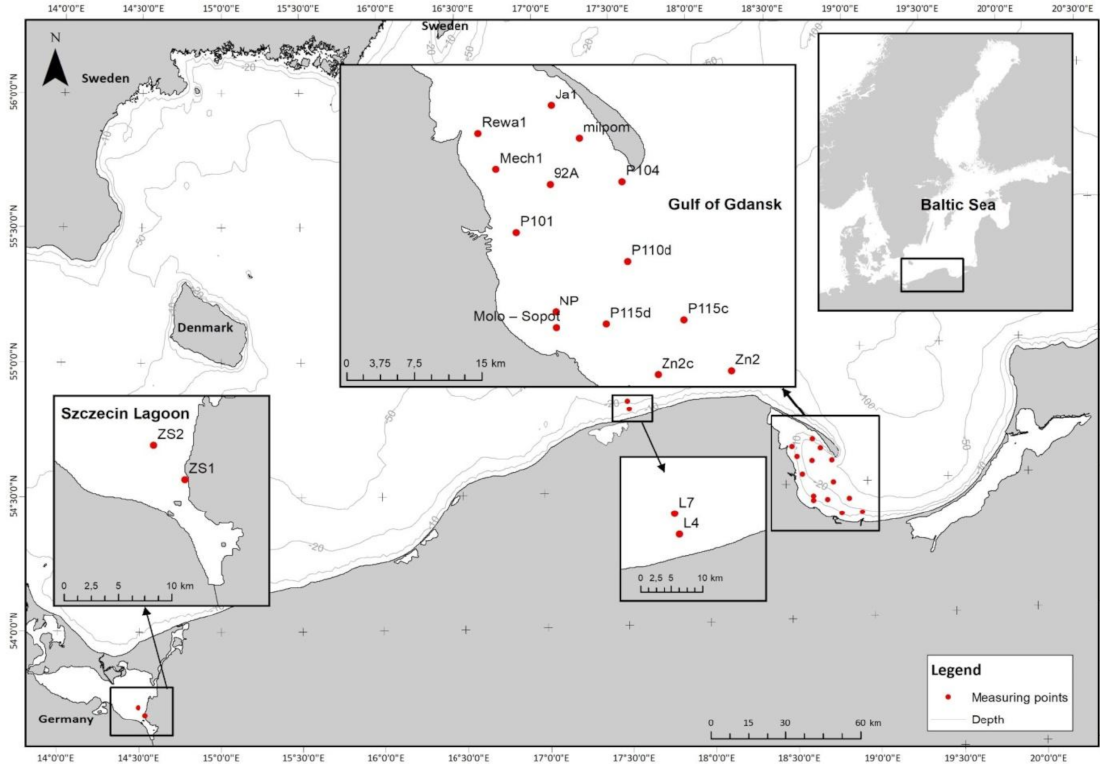
Figure 2. Locations of the study area and sampling